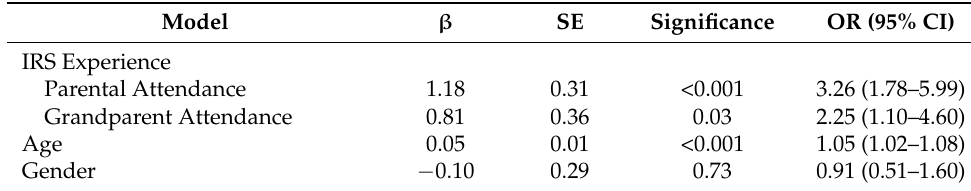
Table 3. Logistic regression analysis predicting time spent in the Child Welfare